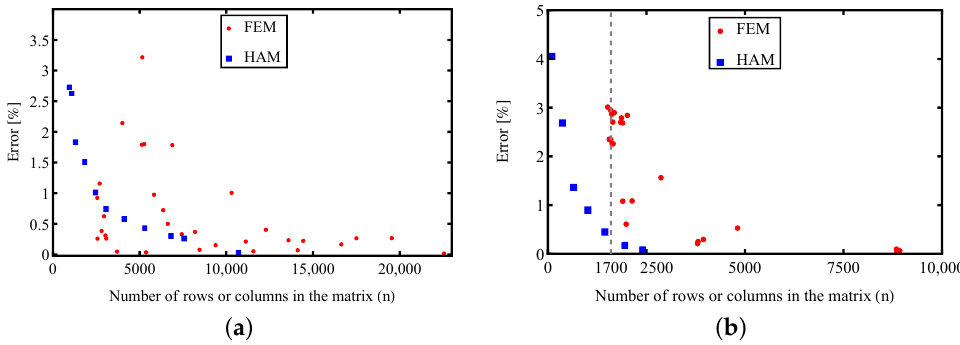
Figure 23. Torque error for different divisions in the HAM and FEM as a function of the sizes of the matrix (n × n): ( a ) Machine I with a current of 4 A (maximal amplitude). ( b ) Machine II with a current of 10 A (maximal